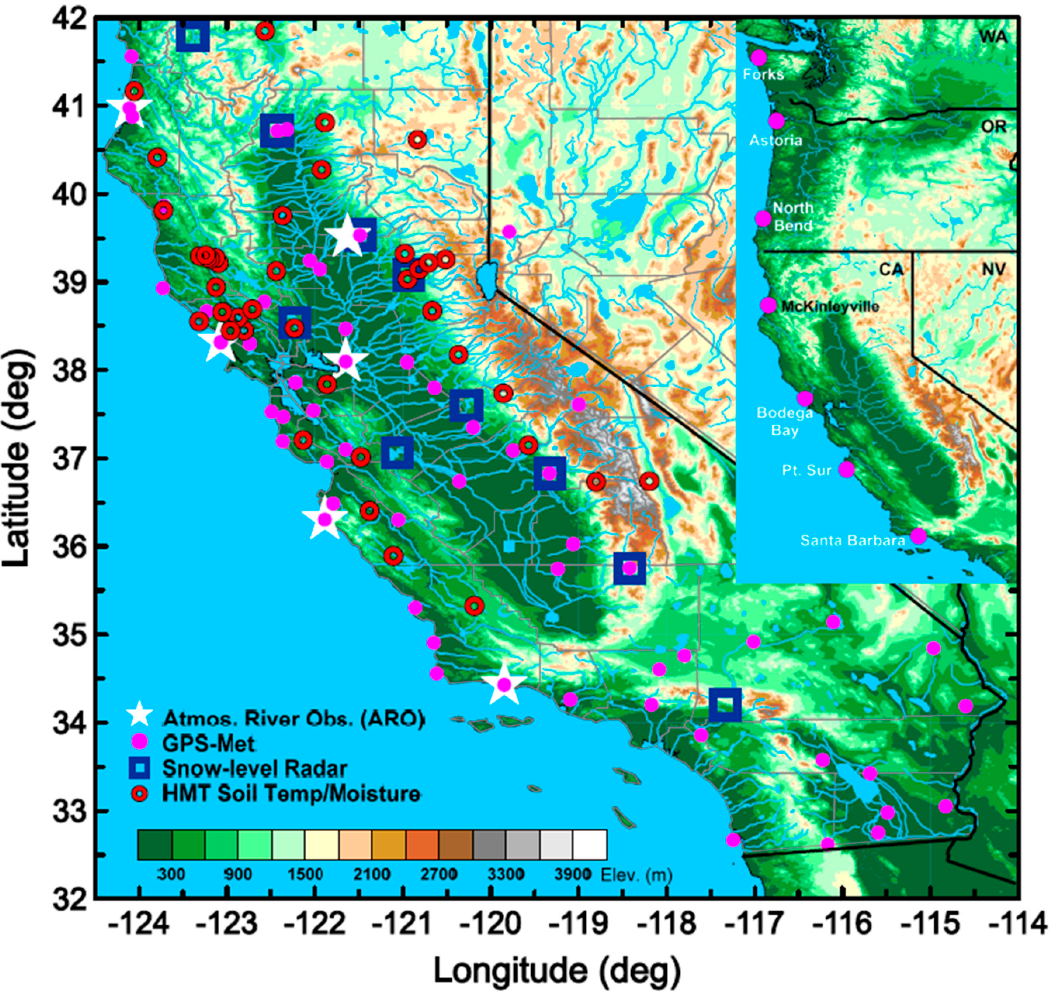
Figure 1. HMT–West LON observing network map. GPS-Met refers to Global Positioning Station meterological stations. Inset shows the “picket fence,” of Atmospheric River Observatories (ATmos. River Obs. Or ARO) including Oregon and Washington coastal AROs. Two inland ARO stations were added after the 2017 flooding. Adapted from [1,25].